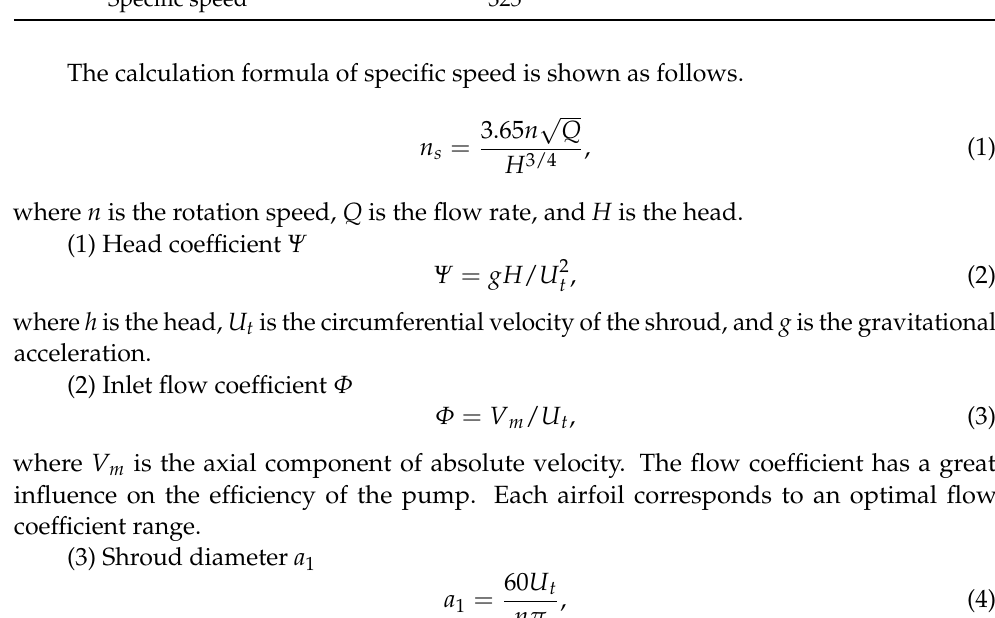
Table 1. Multiphase pump design working parameters. Design Parameter Value Unit Rotation speed 4500 rpm/min Flow rate 35 L/s Head m Specific speed